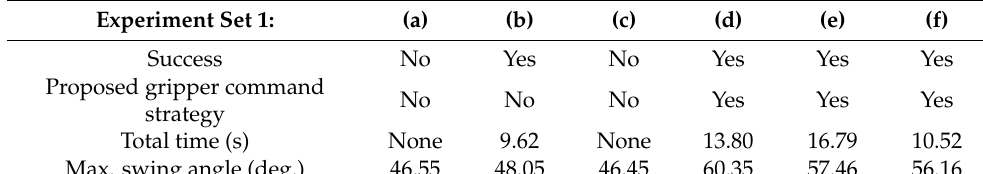
Table 4. Experimental results obtained in the first set of experiments.